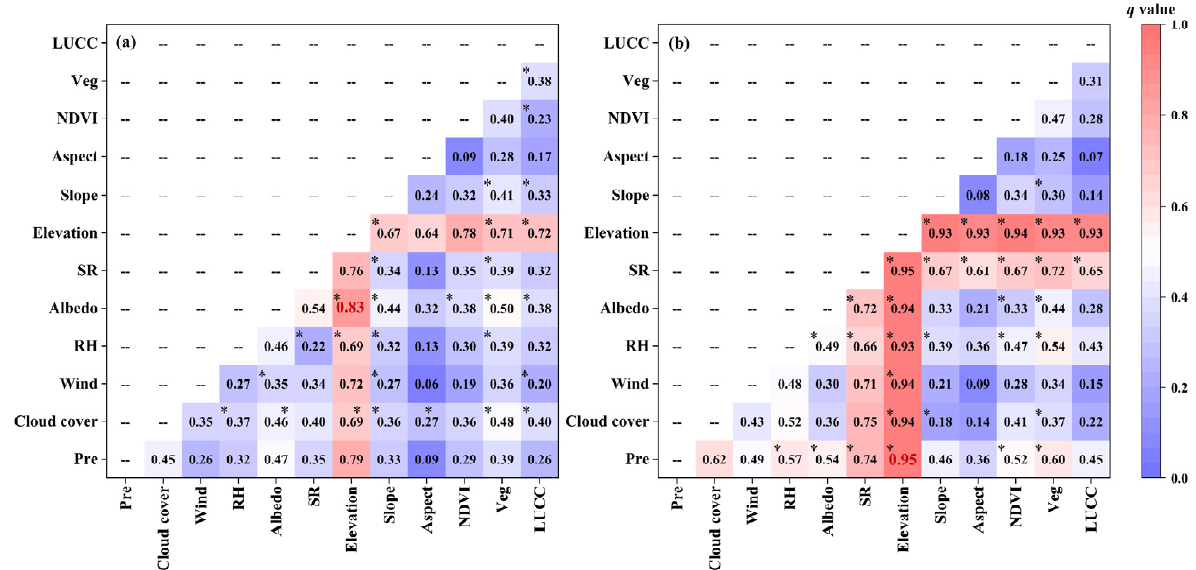
Figure 9. Interaction detection of driving factors in the ( a ) daytime and ( b ) nighttime. Notes: The asterisks indicate that the interaction between the two factors is bivariate enhancement; unmarked indicates that the interaction between the two factors is nonlinear enhancement; “–” indicates no data. The value and color of each box represent the strength of the interaction between the two factors on surface temperature in both horizontal and vertical coordinates; the greater the value, the darker the red color and the stronger the interaction; the lower the value, the darker the purple color and the weaker the interaction.